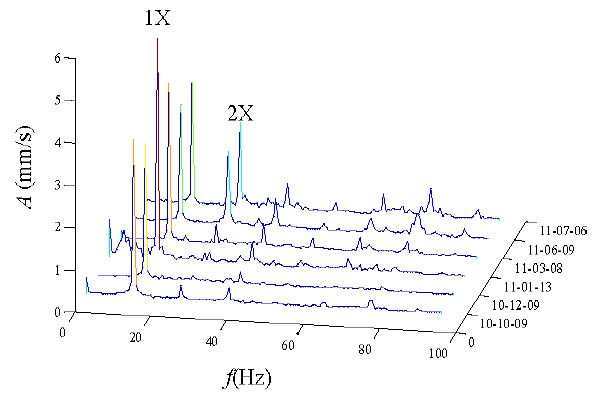
Figure 6. The FFT waterfall from 0 to 100 Hz of the No. 2H sensor.